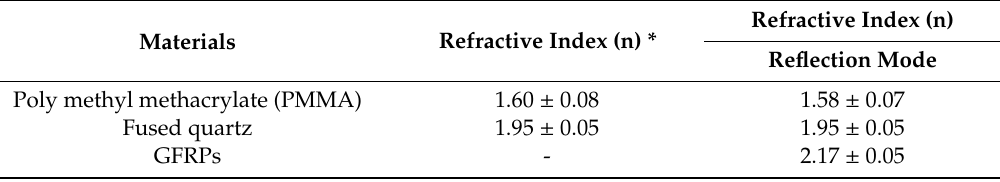
Table 1. Average T-ray refractive indices of the various